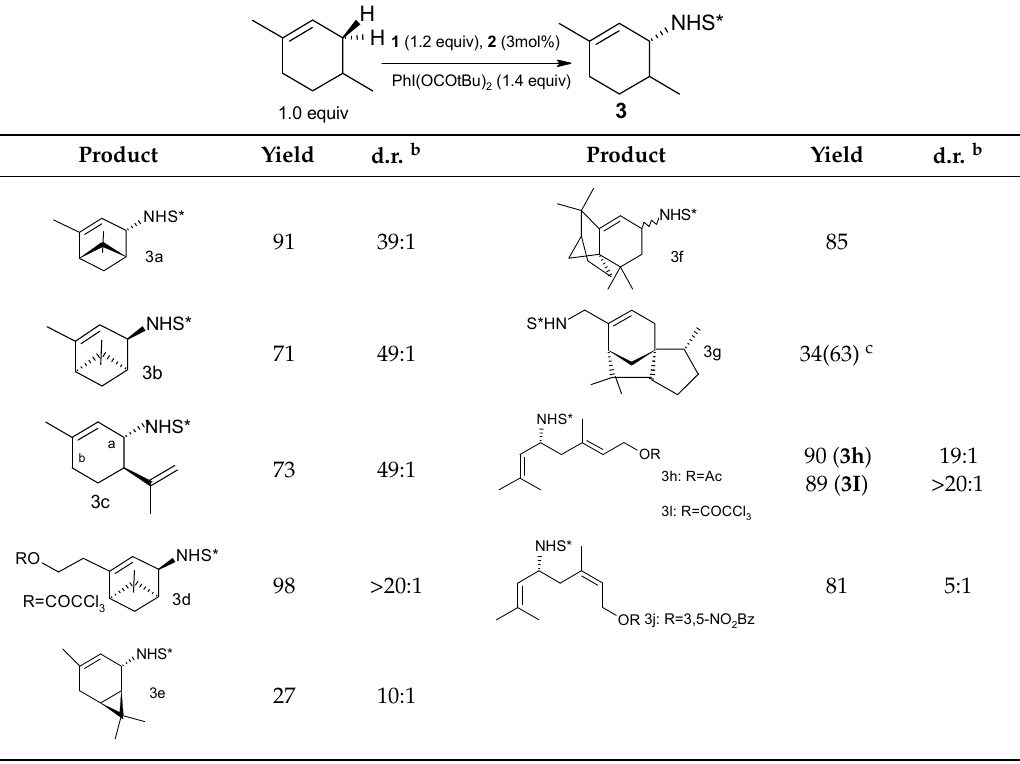
Figure 28. Sulfonimidamide S*NH 2 ( 1 ) and the rhodium catalyst Rh 2 (S-nta) 4 ( 2 ). Reproduced with permission from [144]. Copyright American Chemical Society.